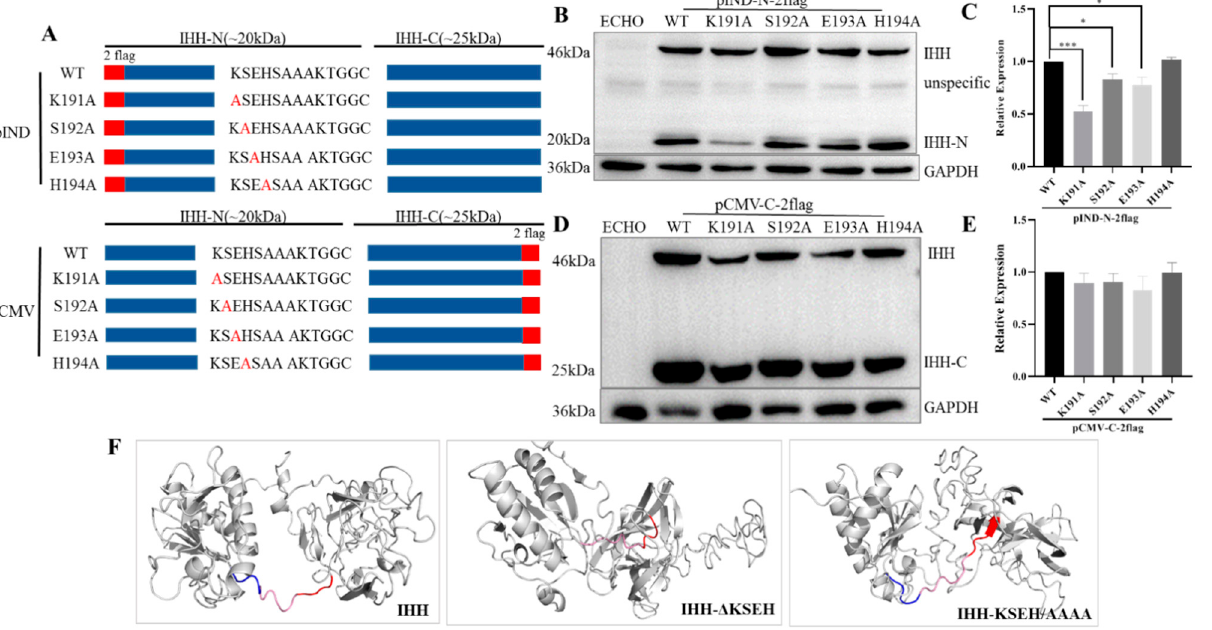
Figure 4. Analysis of point mutations in KSEH region and structural simulation of KSEH mutations. ( A ) Schematic of point mutations in KSEH. Red letters indicate mutant amino acid. ( B , C ) Western blot and statistical analysis showed that IHH-N could be detected in the corresponding point mutant constructs, but it was obviously reduced in K191A mutation and slightly reduced in S192A and E193A mutations, indicating that these amino acids may have a fractional effect on protein stability. Data are mean ± s.e.m, n = 3, * p < 0.05, *** p < 0.001. ( D , E ) Western blot and statistical analysis ( n = 3) showed that the expression levels of IHH-C were statistically similar to those of WT, suggesting that KSEH worked together for IHH self-cleavage. ( F ) Structural simulation of IHH protein showed that the C -terminal region, including cholesterol modification site G202 (blue, KSEH; pink, SAAAKT; and red, GGCF), was presented on the surface as α -helices in WT IHH but covered and changed to an aperiodical coil in KSEH truncation and KSEH/AAAA replacement. This finding indicated that KSEH was critical for the surface presentation of the self-cleavage site on IHH protein.